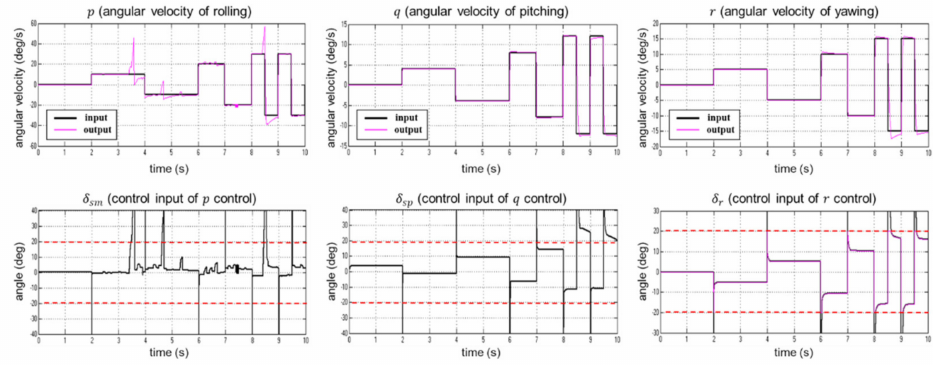
Figure 11. PID control simulation results with large disturbances (variance of magnitude = 10).